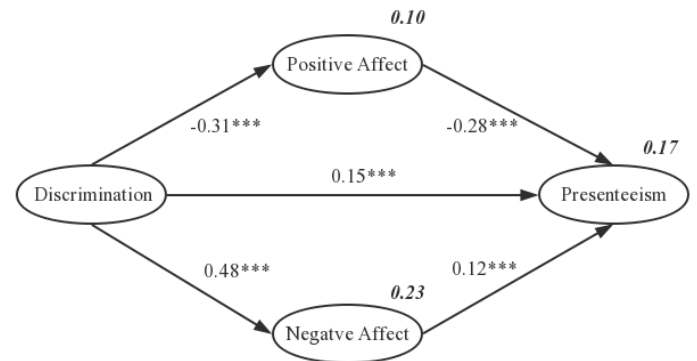
Figure 2. Mediator model of how discrimination influences presenteeism via positive and negative affect. ( The numbers not in bold are standardized regression coefficients; numbers in bold explain variability; chi-square = 3293.822; degrees of freedom = 480, p < 0.001; root mean square error of approximation = 0.052; normed fit index = 0.908; comparative fit index = 0.920; goodness-of-fit index = 0.913; *** p < 0.001.)